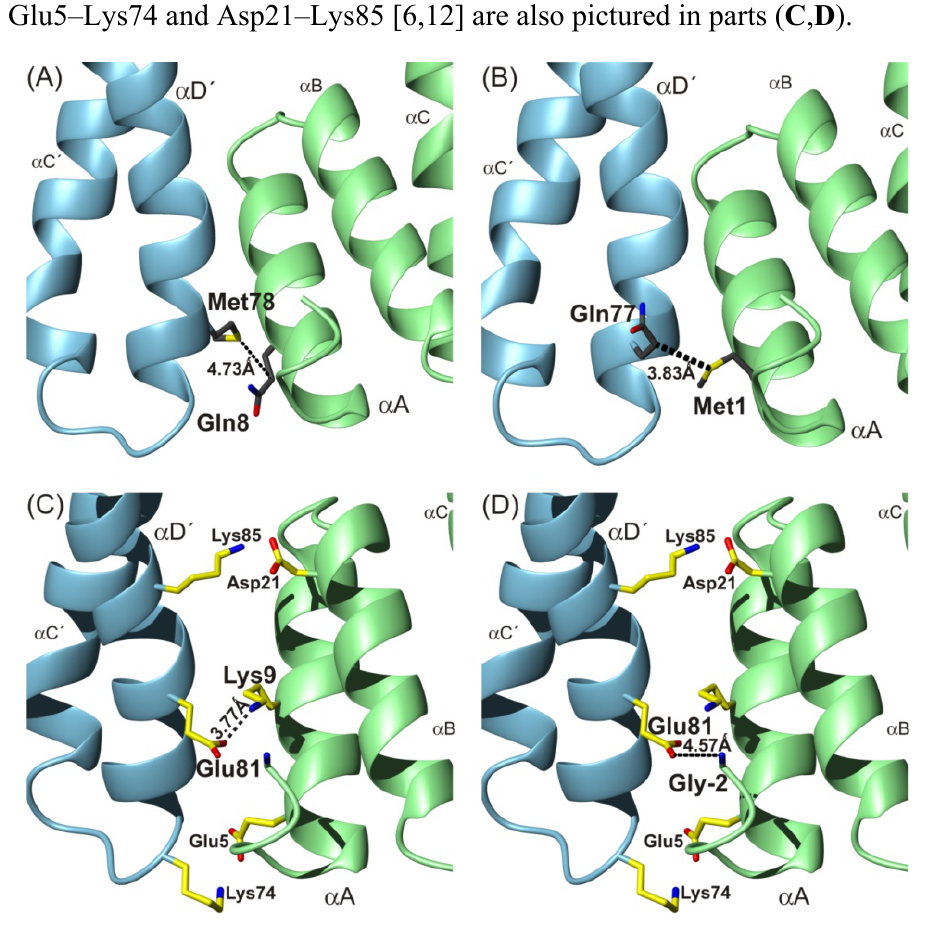
techniques. The detected contacts are shown in the adapted 3rdh X-ray [7] structure of 14-3-3 ζ homodimer using molecular dynamic technique: Gln8–Met78 ( A );